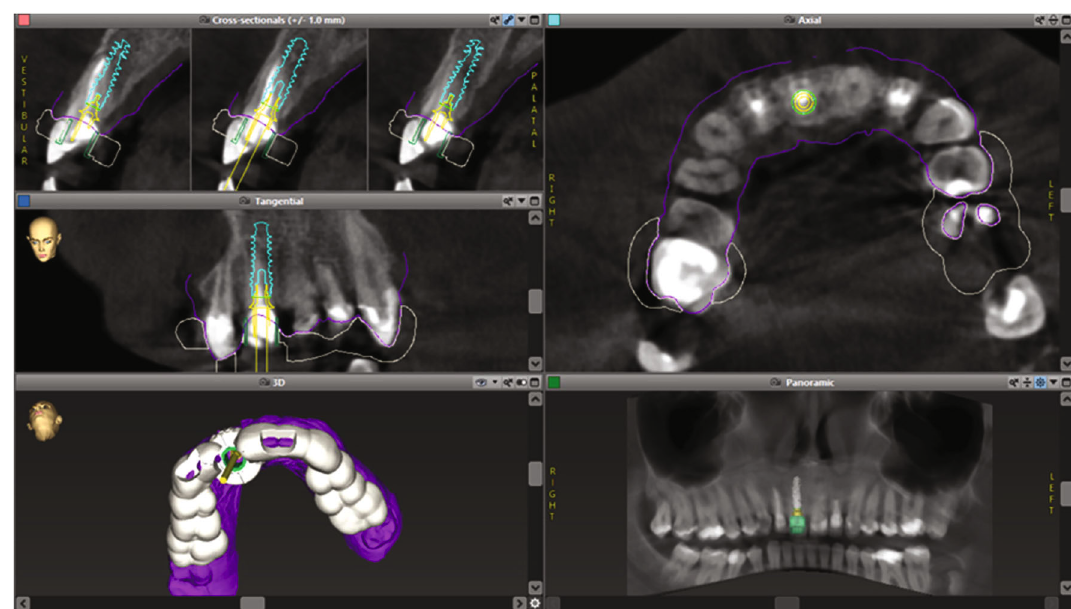
Figure 1: The virtual planning in the specialist